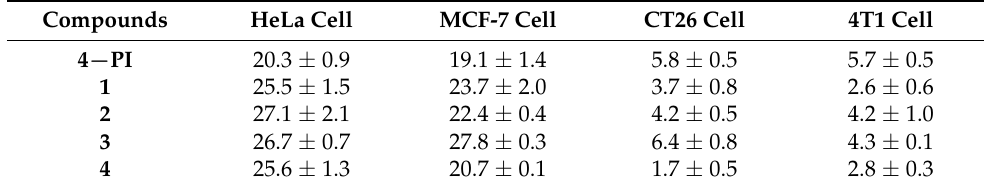
Table 2. Inhibition (%) at 100 µ M inhibitor concentration a . Compounds